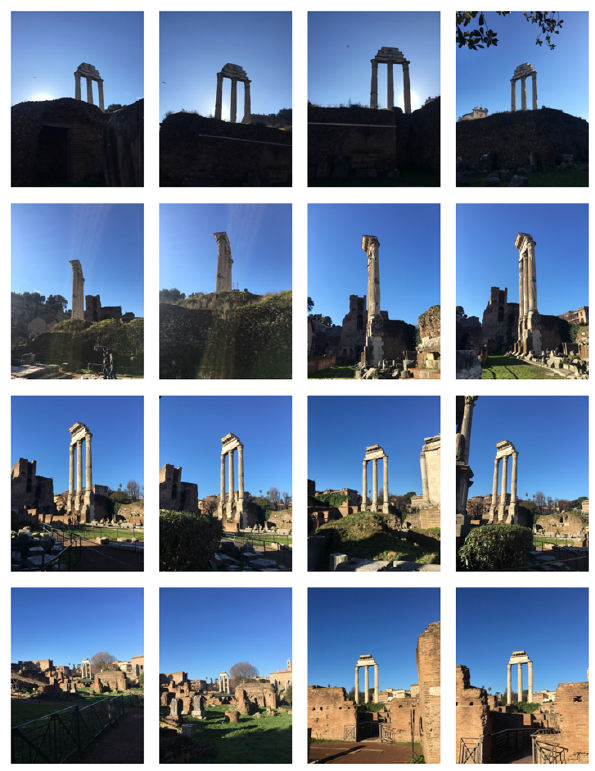
Figure 3. Sample from the original (not augmented) set of training images for the Temple of Castor and Pollux. Panoramic views and pictures showing not optimal lighting conditions were maintained to simulate user’s